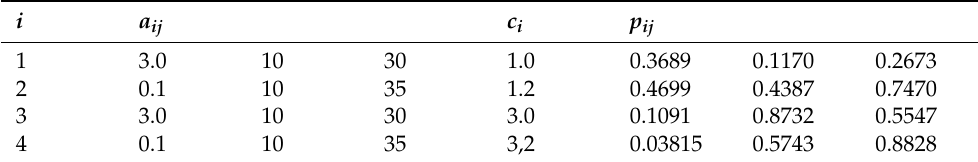
Table 4. Parameters of the Hartman function.